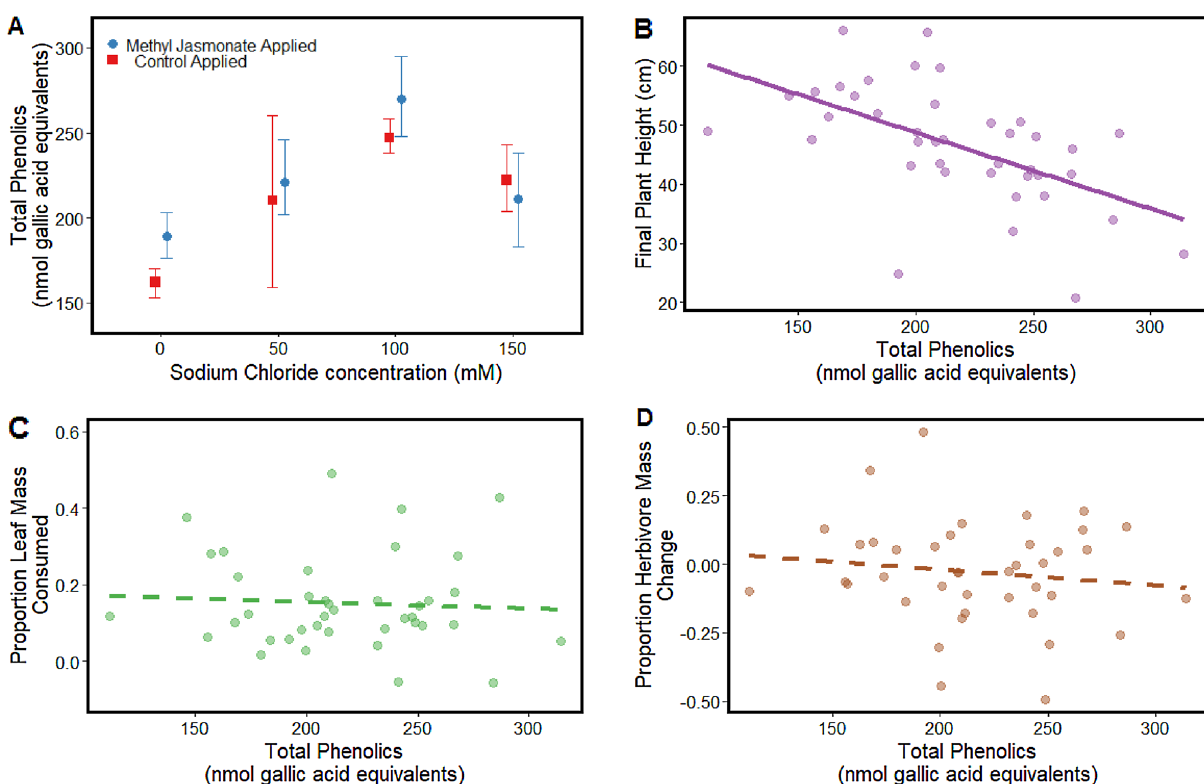
Figure 2. Effects of soil salinization at four concentrations of salt addition (0, 50 100, 150 mM NaCl) and plant induction via exogenous application of methyl jasmonate on ( A ) Folin-Ciocalteu reagent-based estimates of total oxidative substrates in leaf tissues. Correlation of total oxidative substrates in leaf tissue with ( B ) final plant height, ( C ) proportion leaf mass consumed, and ( D ) proportion herbivore mass change. Solid trend lines indicate statistically significant (Type I Error < 0.05) correlation between responses; dashed trend lines indicate no significant correlation between responses (Type I Error > the different MeJA treatments (F 1,32 = 1.48, P = 0.232) nor did the effects of MeJA treatment on total leaf phenolics vary by NaCl treatment (NaCl treatment × MeJA induction treatment: F 3,32 = 0.686, P = 0.567). Additionally, for the subset of lab herbivory samples for which we have leaf phenolics and oxidative substrates estimates, final plant height was significantly lower in plants with greater concentrations of total leaf phenolics (Fig. 2B; β = − 0.129, r adj = 0.297, F 1,38 = 17.48, p < 0.001). However, neither proportion leaf tissue consumed (Fig. 2C) nor proportion herbivore mass change (Fig. 2D) correlated with total phenolics and other oxidative substrates (all p values > 0.416). Herbivores feed on diets of tomato leaves treated with 100 mM or 150 mM NaCl solution were almost twice as likely to die during the observation period (100 mM NaCl, Coef = 1.79, z = 2.28, p = 0.022; 150 mM NaCl, Coef = 2.10, z = 2.70, p = 0.007) than herbivores fed exclusively from the control treated plants (Fig. 3; χ 2 = 12.31, d.f. = 3, p = 0.006). Herbivores fed for a prolonged period on a diet restricted to leaves from plants treated with methyl jasmonate tended to die more quickly than individuals feed on a diet of leaves from plants treated with the control solution (Figure S3; Coef = 1.38; χ 2 = 3.59, d.f. = 1, p = 0.058). In these controlled feeding trials, the frequency of pupation deviated from expected equivalent distributions between soil salinization treatment lev- els (Fig. 4A, B; χ 2 = 21.01, d.f. = 3, p < 0.001) and between MeJa treatment levels (Fig. 4C, D; χ 2 = 4.17, d.f. = 1, p = 0.041).